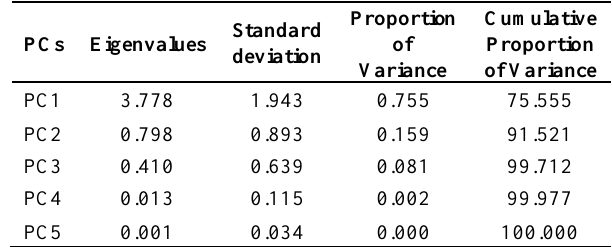
Table 4. Results of all major PCs and its variance